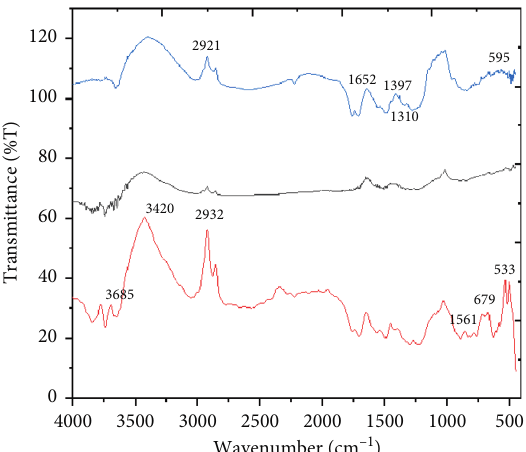
Figure 2: FTIR spectra of APC (a) before adsorption; (b) after CR adsorption; (c) after SF adsorption.